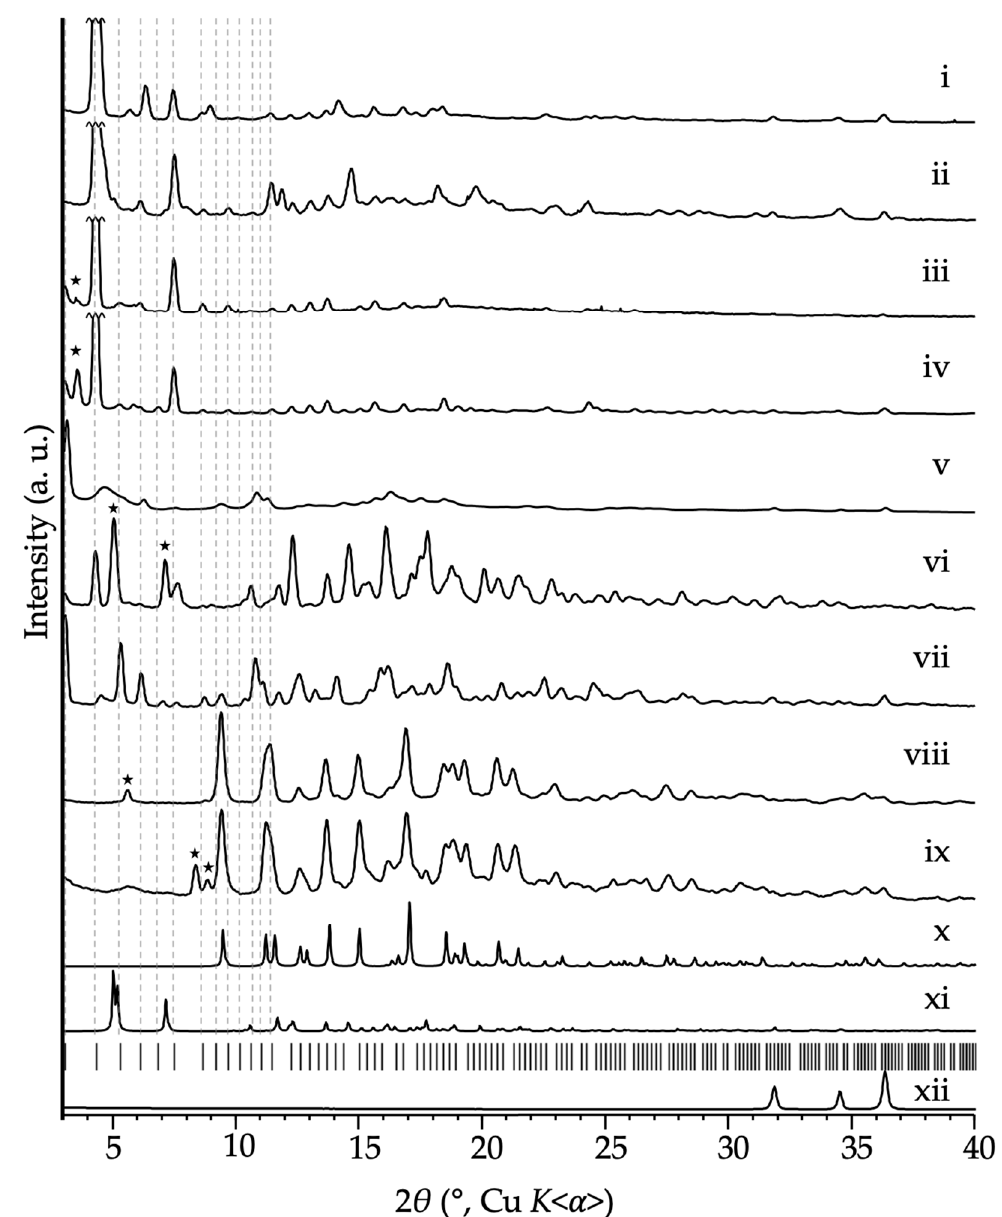
Figure 5. Experimental PXRD patterns of LAG-aging syntheses using nanoparticulate ZnO, imidazole, DEF, and selected cavitands, washed after t days. (i) cavitand = MeHCH 2 , t = 16 d, (ii) cavitand = Me i BuCH 2 , t = 16 d, (iii) cavitand = BrPhCH 2 , t = 7 d, (iv) cavitand = BrC5CH 2 , t = 5 d, (v) HPhCH 2 , t = 12 d, (vi) cavitand = MePhCH 2 ( rctt : rccc = 87:13), t = 5 d, (vii) cavitand = MeHCH 2 -6 , t = 5 d, (viii) MeHSiMe 2 , t = 11 d, (ix) H(4MePh)CH 2 , t = 11 d, and (xii) nanoparticulate ZnO. Simulated PXRD patterns of (x) cag -Zn Im 2 (VEJYUF) and (xi) nog -Zn Im 2 (HIFWAV). Tick marks denote predicted peak positions of 0.90 MeMeCH 2 @RHO-Zn 16 Im 32 . Stars denote small amounts of impurities that are not defined in Table 1.